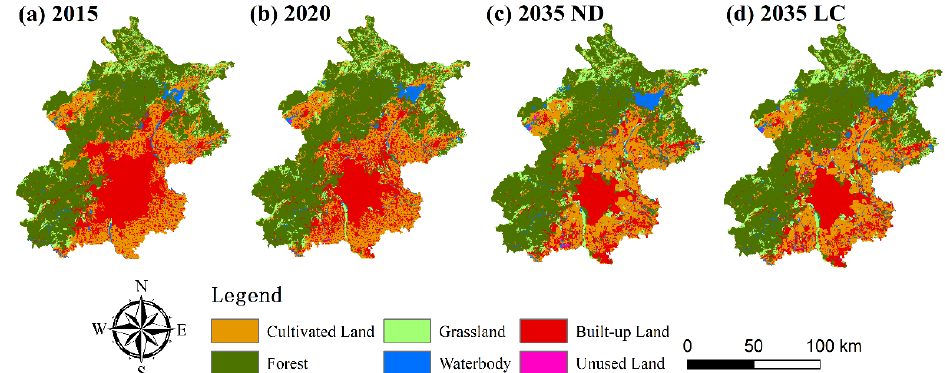
Figure 3. Land use:(a) year 2015; (b) year 2020 and simulation results in 2035: (c) ND Scenario; (d) LC